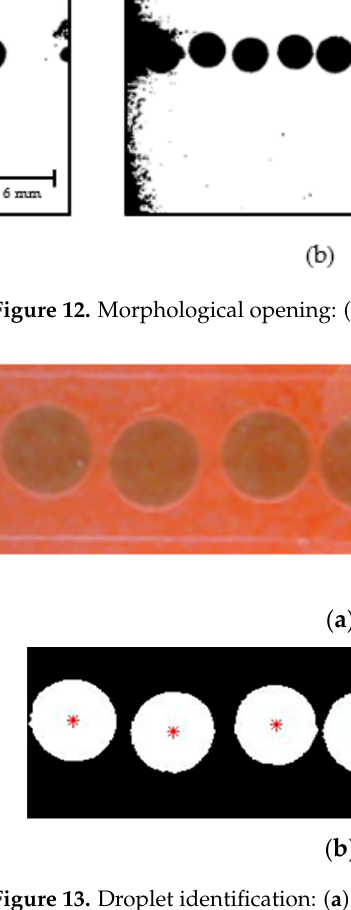
Figure 12. Morphological opening: ( a ) Binary image; ( b ) Opening step 1; ( c ) Opening step 2.